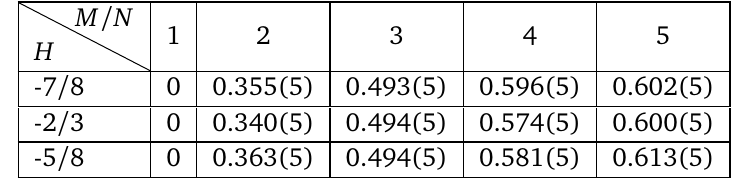
Table 6: Best fit parameter c (52).